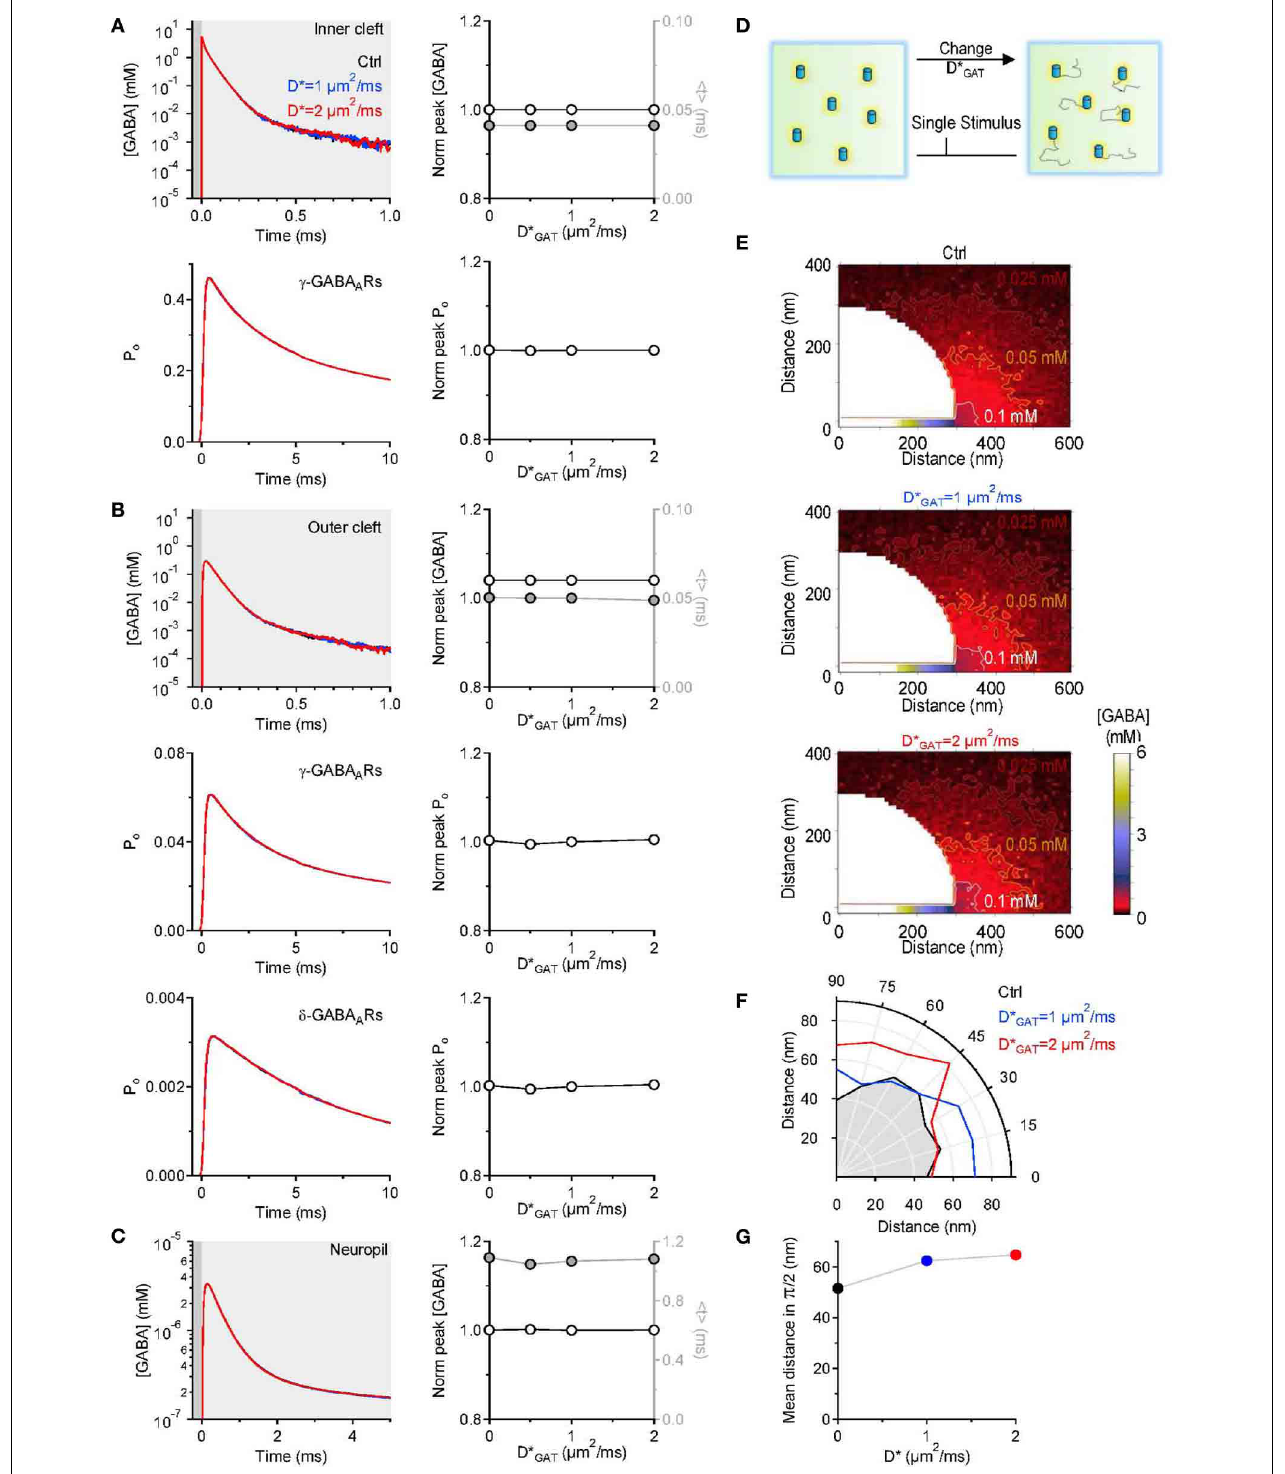
FIGURE 5 | Changing the lateral mobility of GABA transporters alters spatial spread but not the lifetime of GABA outside the synaptic cleft. (A) GABA concentration profile in the inner cleft volume measured when varying the lateral mobility of GABA transporters in the entire simulation environment (top left). The centroid ( < t > ) of the GABA concentration profile